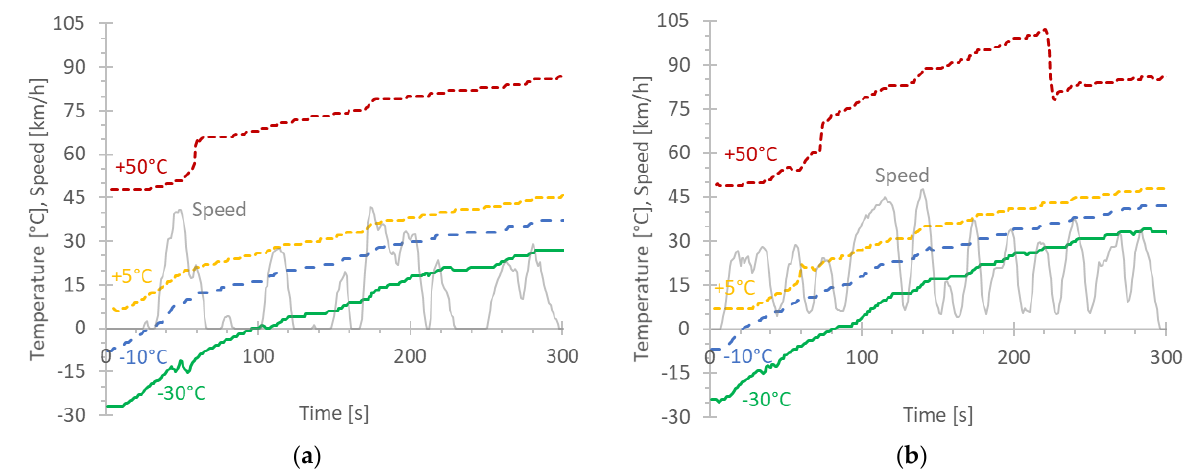
Figure A1. Coolant temperature during cold start (300 s): ( a ) TfL; ( b ) RDE short.